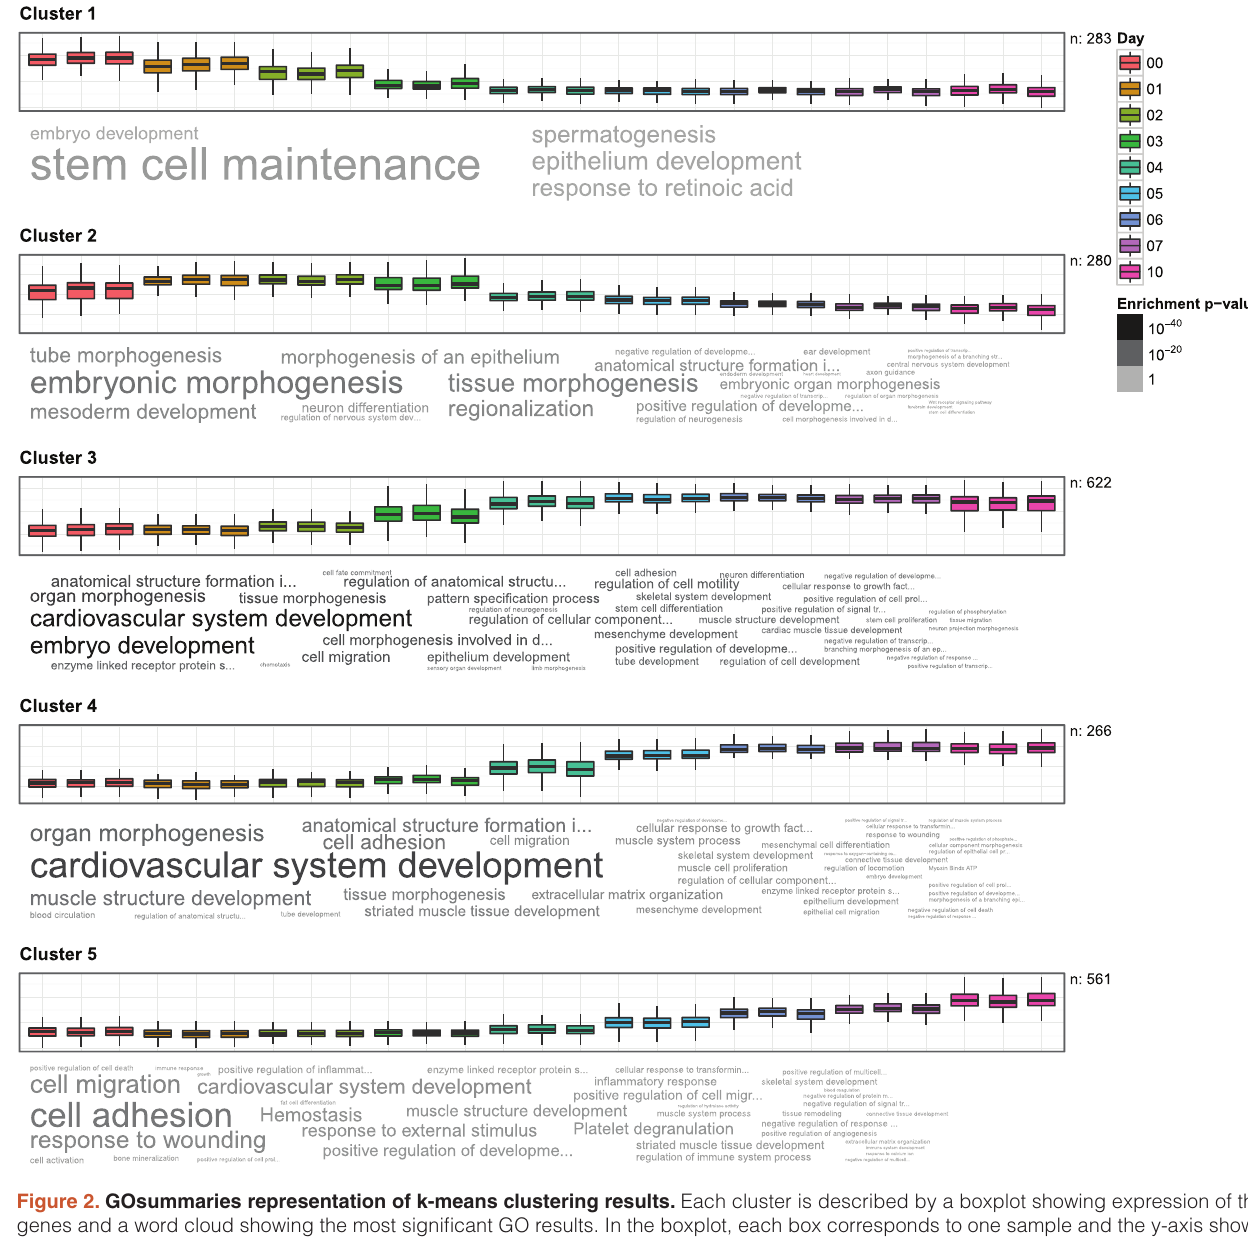
of enrichment p-value within one word cloud. The 10